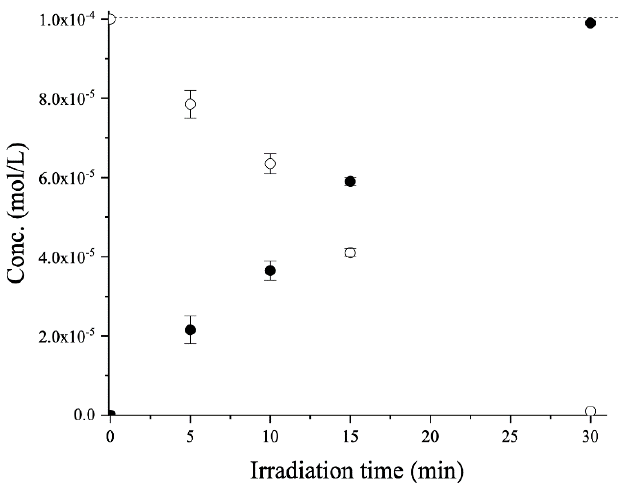
Figure 6. Time courses of NBA (1 × 10 − 4 M, empty circles) and of ABA (full circles) during irradiation ( λ ≥ 420 nm, 25 °C) of CdS/TiO 2 -2 (3 g/L) suspended in a deaerated CH 3 CN/2-PrOH (4/1) reaction mixture. The horizontal dotted line represents the initial amount of NBA in the reaction container and allows evidencing the almost complete transformation of NBA in ABA product (yield > 95%).